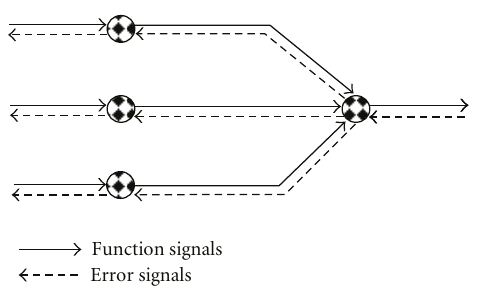
Figure 4: Illustration of the directions of two basic signal flows in a multilayer perceptron: forward propagation of function signals and backpropagation of error signals [20].